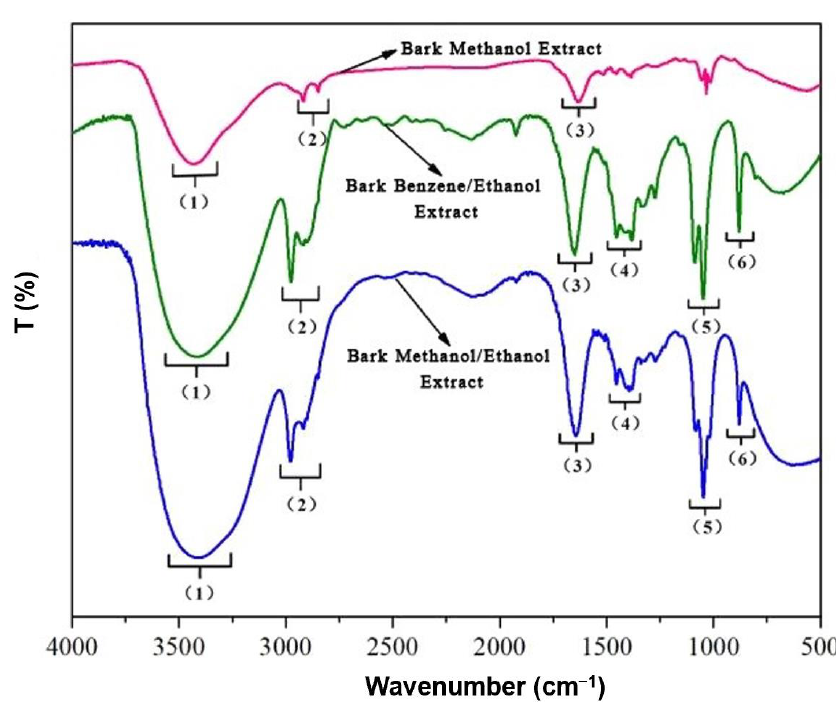
Figure 5. The FT-IR spectra of the RPB extracts. The absorption peaks of the extracts were mainly concentrated in the 3730–3000 cm − 1 , 1750–1550 cm − 1 , and 1100–850 cm − 1 bands. Absorption peaks were formed by shaking or anti-stretching vibrations of free hydroxyl groups in liquid water in the 3400 cm − 1 or higher IR spectrum. The appearance of the absorption peak at 3400–3300 cm − 1 was formed by NH 2 symmetric and antisymmetric stretching. Furthermore, the appearance of the absorption peak at 3030 cm − 1 represented stretching vibrations of -CH bonds. These two peaks indicate the presence of phenols and alcohols in the extract. The absorption peaks that appeared at 1730–1550 cm − 1 were caused by stretching vibrations of C=O double bonds. This position indicates the presence of esters, ketones, and acids in the extract. The absorption peak appearing in the 1100–850 cm − 1 band was caused by NO 3 − symmetric stretching, and the absorption peak at 900 cm − 1 was formed by bending COH out-of-plane. The cellulose absorption peak (3500–3300 cm − 1 ) decreased significantly, indicating hydrolysis of cellulose [41]. The hemicellulose (3400 and 2970 cm − 1 ) and lignin (1470–1430 cm − 1 ) absorption peaks decreased slightly, indicating that hemicellulose and lignin were less hydrolyzed than cellulose [42,43]. Comparing the three graphs at the absorption peak of 3400 cm − 1 , the absorbance of the bark samples-1 methanol extract decreased less, while the absorbance of the bark samples-2 benzene/ethanol extract and bark samples-3 methanol/ethanol extract decreased significantly, indicating that ethanol is a more suitable extraction solvent to extract phenolic substances. Phenolic compounds during organic solvent